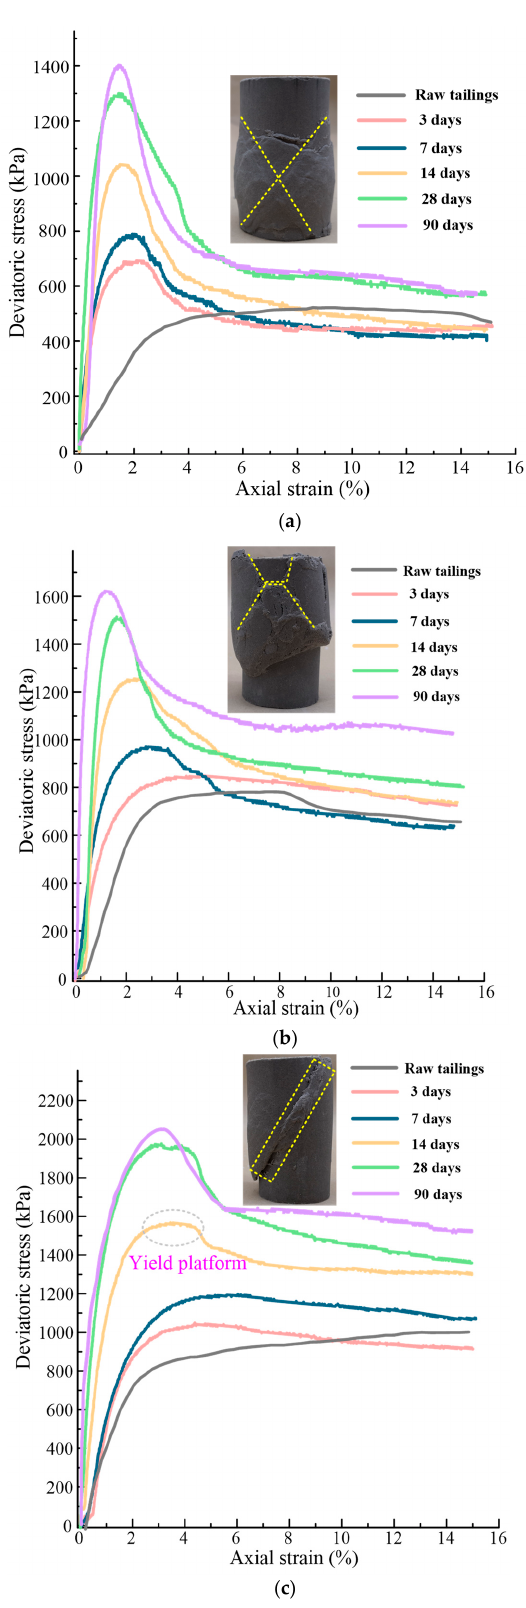
Figure 4. Stress ‐ strain curves and failure deformation of the stabilized/solidified gold tailings: ( a ) under confining pressure of 100 kPa, ( b ) under confining pressure of 200 kPa, and ( c ) under confin ‐ ing pressure of 400 kPa.